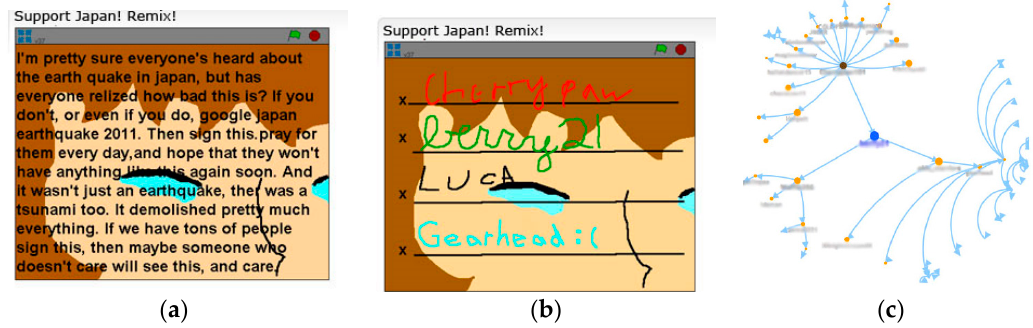
Figure 3. ( a ) A project calling Scratch members to sign a “petition” to support Japan; ( b ) Screenshot of project that remixed the original and signed the “petition”; ( c ) The resulting remix tree of this project--each node is a project and a link connects the original project to a